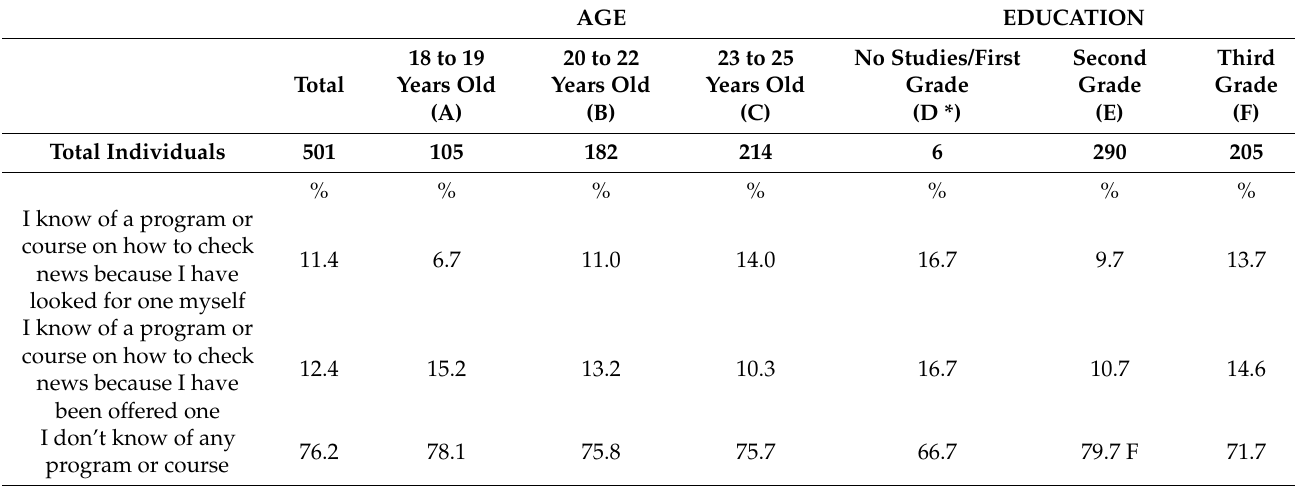
Table 3. Question 16: Which of these statements best fits your situation regarding your training in fake news?